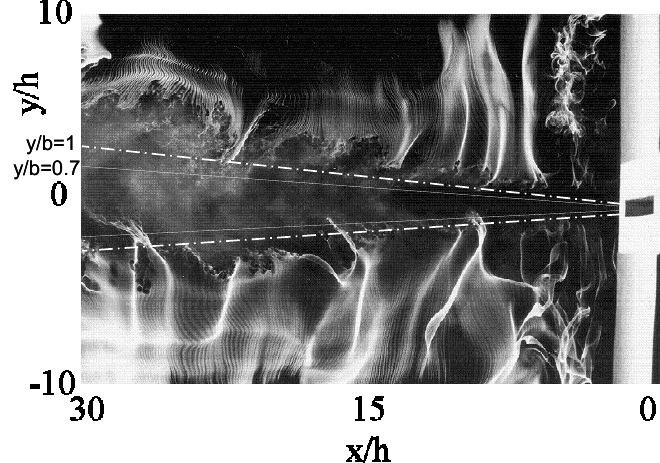
Fig. 10 Visualization of the jet using smoke wire ( Re =3.0×10 4